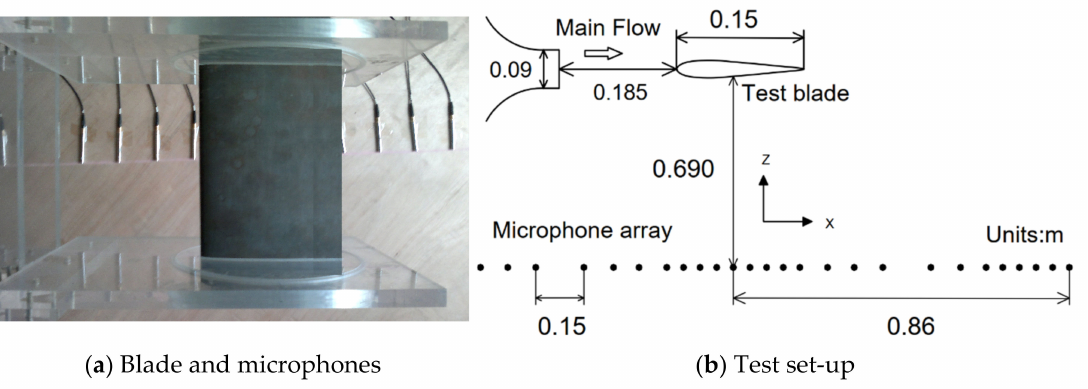
Figure 8. Microphone array and the test